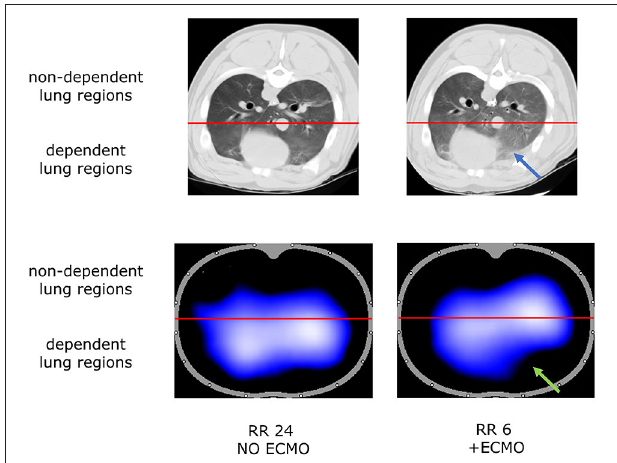
FIGURE 2 | Representative CT scan (aeration at end expiration, Top ) and Electrical Impedance Tomography (ventilation at end-inspiration, Bottom ) images during RR 24 and RR 6 step from one representative animal. Blue arrow indicates lung collapse at CT scan; green arrow indicates the correspondent loss of aeration detected by EIT